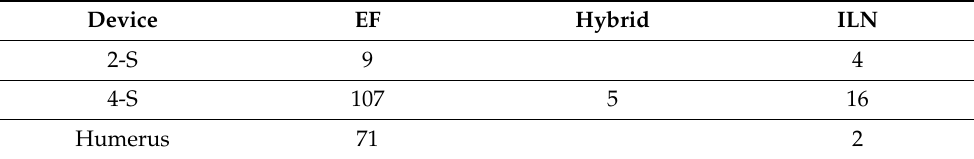
Table 2. Lengthening types by devices.